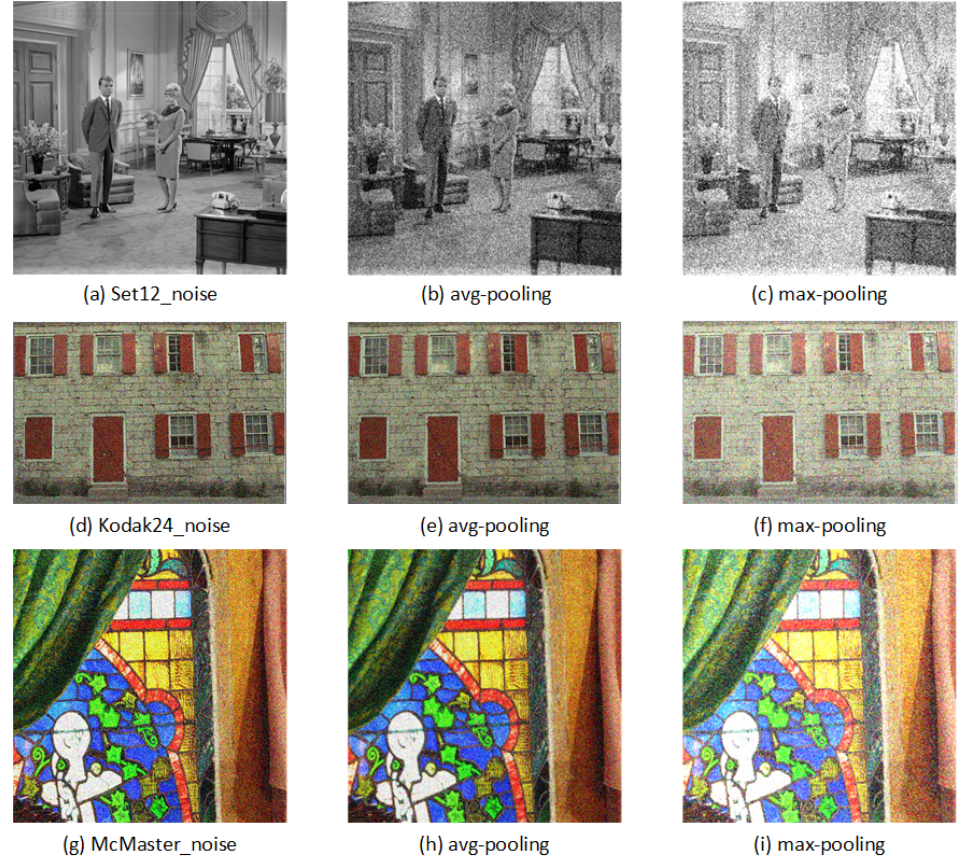
Figure 10. A comparison of avg-pooling and max-pooling. (The noise level σ =